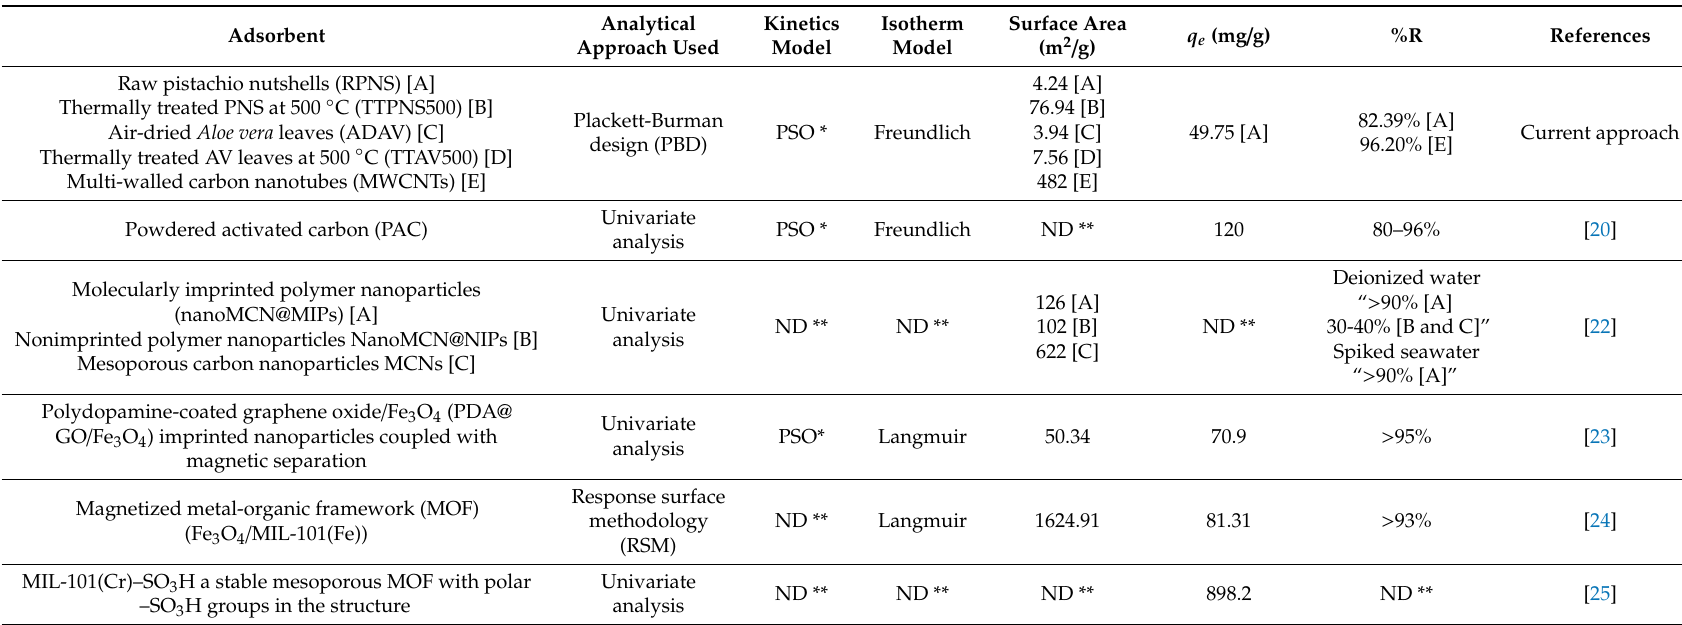
Table 1. Reported adsorption – based methods for removal of